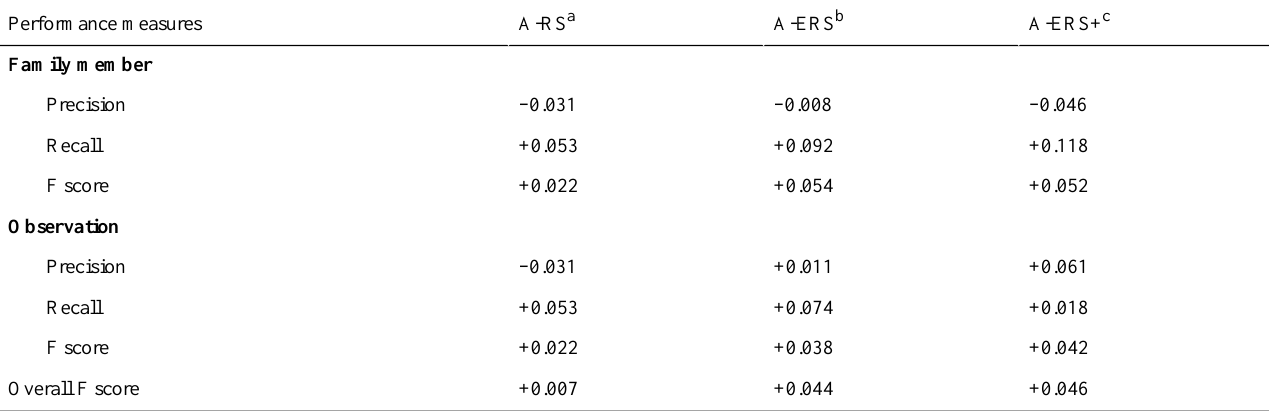
Table 4. Comparison of the performance of the different attention-enhanced bidirectional long short-term memory-conditional random field (BiLSTM-CRF)